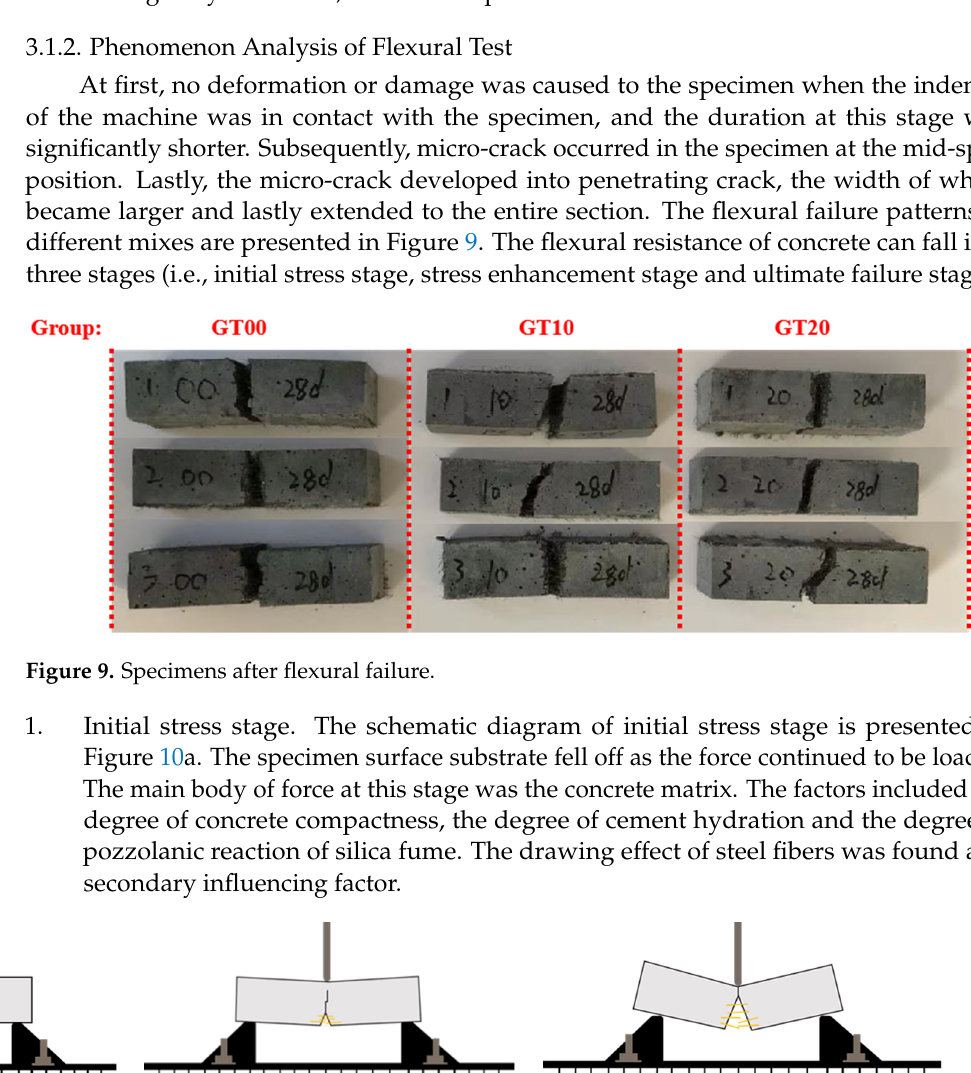
Figure 10. Schematic diagram of the bending resistance stage of the specimen. ( a ) Initial stress stage; ( b ) Stress enhancement stage; ( c ) Ultimate failure stage.